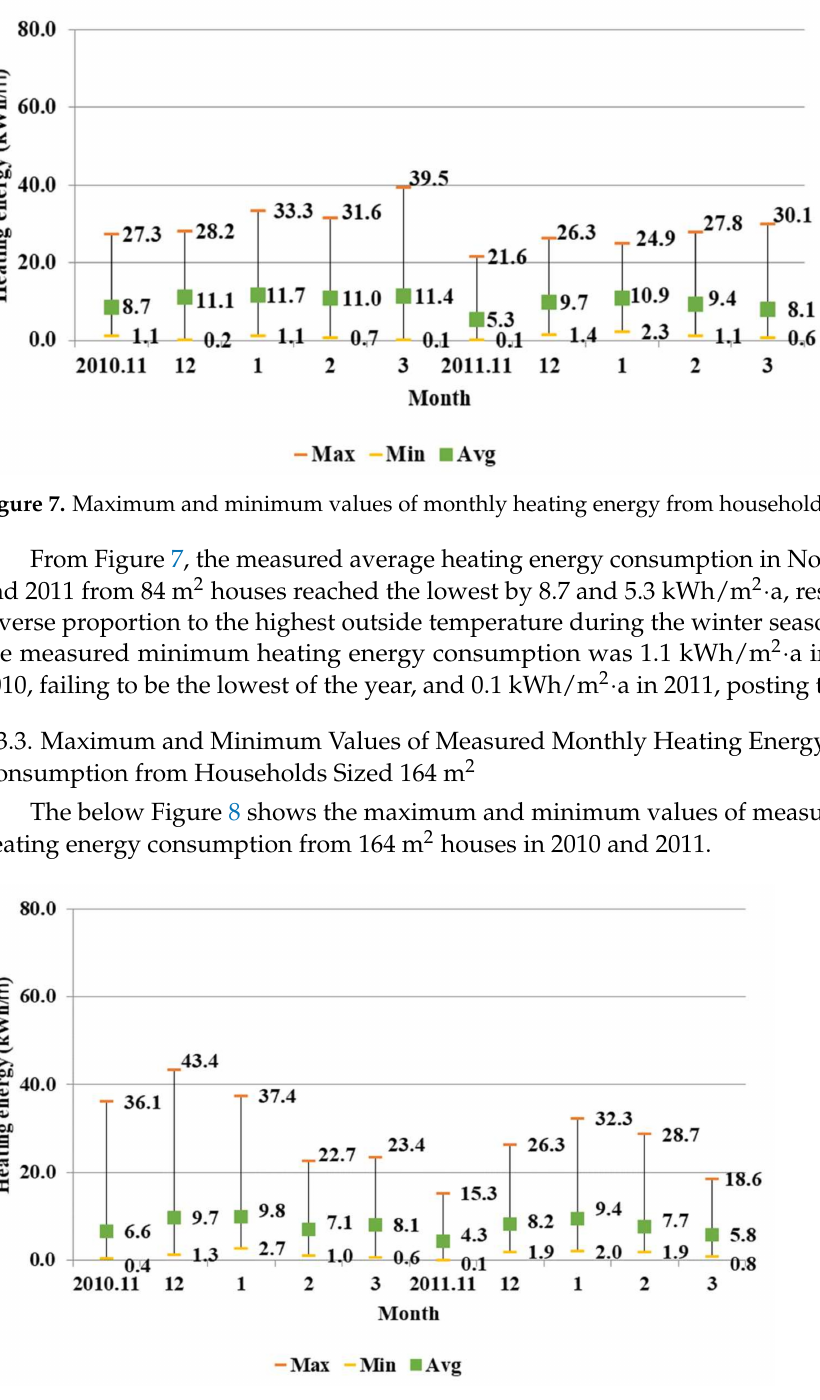
Figure 8. Maximum and minimum values of monthly heating energy from households sized 164 m 2